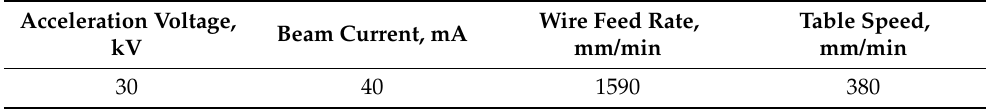
Table 1. The additive process